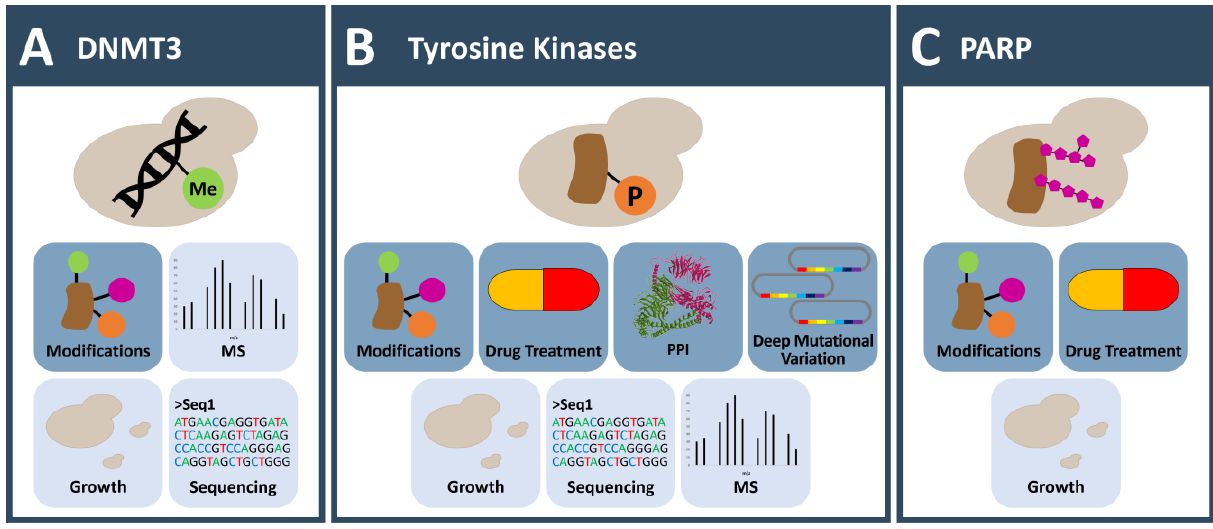
FIGURE 1: Applications to investigate DNA methylation and post translational protein modifications otherwise absent in yeast. (A) Yeast is used as a model organism to investigate cytosine DNA methylation induced de novo via human DNMTs. A special focus lies on the inter- play with histone modifications. (B) Tyrosine kinases are lacking in yeasts and their activity can be toxic. This allows the investigation of protein variants (in deep mutagenesis screens) that govern kinase activity and function and enables inhibitor testing. Non-toxic low-level expression of human tyrosine kinases in yeast allows large scale screening of phosphorylation dependent protein interaction and the char- acterization of kinase substrate specificity. (C) PARPs attach ADP-ribose to their target proteins. No such modification is reported in yeast. Expression of PARPs in yeast results in a growth phenotype and allows screening for substrates and small molecule inhibitory drugs. (A-C) Icons with dark blue background: observable; Icons with light blue background: readout; MS: mass spectrometry; PPI: protein-protein-